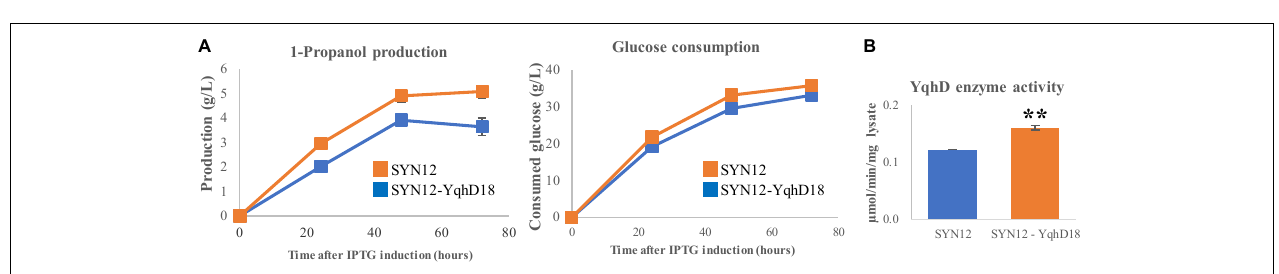
FIGURE 4 | Effect of YqhD expression optimization. (A) 1-Propanol production and consumed glucose. (B) The relative specific activity of YqhD within cell lysate with improved RBS sequence. Asterisks indicate significant difference from the strain (** p < 0.01). The error bars indicate standard deviations obtained from three replicate